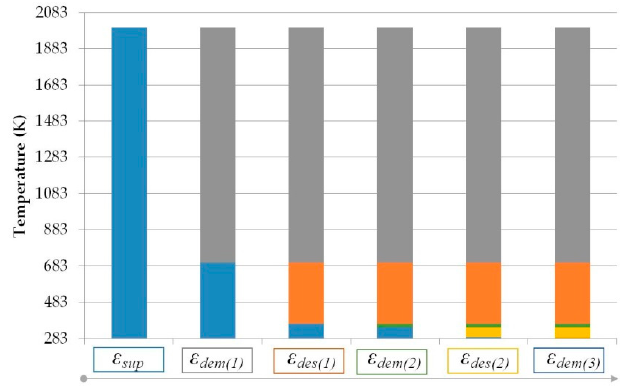
Figure 14. Exergy Flow Bars for a Conventional DE System with Power, Heat, and Cold Supply. The baseline DE system that provides a basis of comparison is to be upgraded to a hydrogen city. Figure 15 puts forth the linkages between the various components in providing exergy supply and useful applications. In the hydrogen city model, the circulation of hot and cold water and any steam is eliminated through the circulation of hydrogen gas, which is less energy intensive. In the upper left component of Figure 15, solar energy is utilized in the PVT-3 system in the plant. First, DC electric power is generated in the PV modules. The heat that is absorbed by the PV coolant is utilized in the thermal charging of the biogas reactor. The exergy flow bar for a typical PVT-3 application at a solar insolation level of 600 W/m 2 is depicted in the form of the upper left bar in Figure 15. Here, the Carnot cycle equivalent temperature for solar energy T fs is by definition the mapped equivalent source temperature for solar energy at a given insolation level I n as given by Equation (17) [64]. This enables an exergy accounting with a more consistent boundary other than a Sun-Earth boundary.